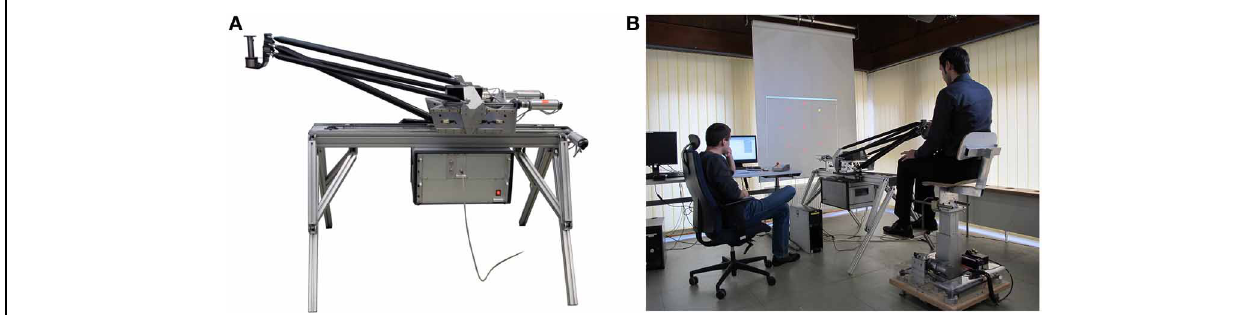
FIGURE 1 | Robotic manipulandum “BioMotionBot” (A), setting of the experiment (B).